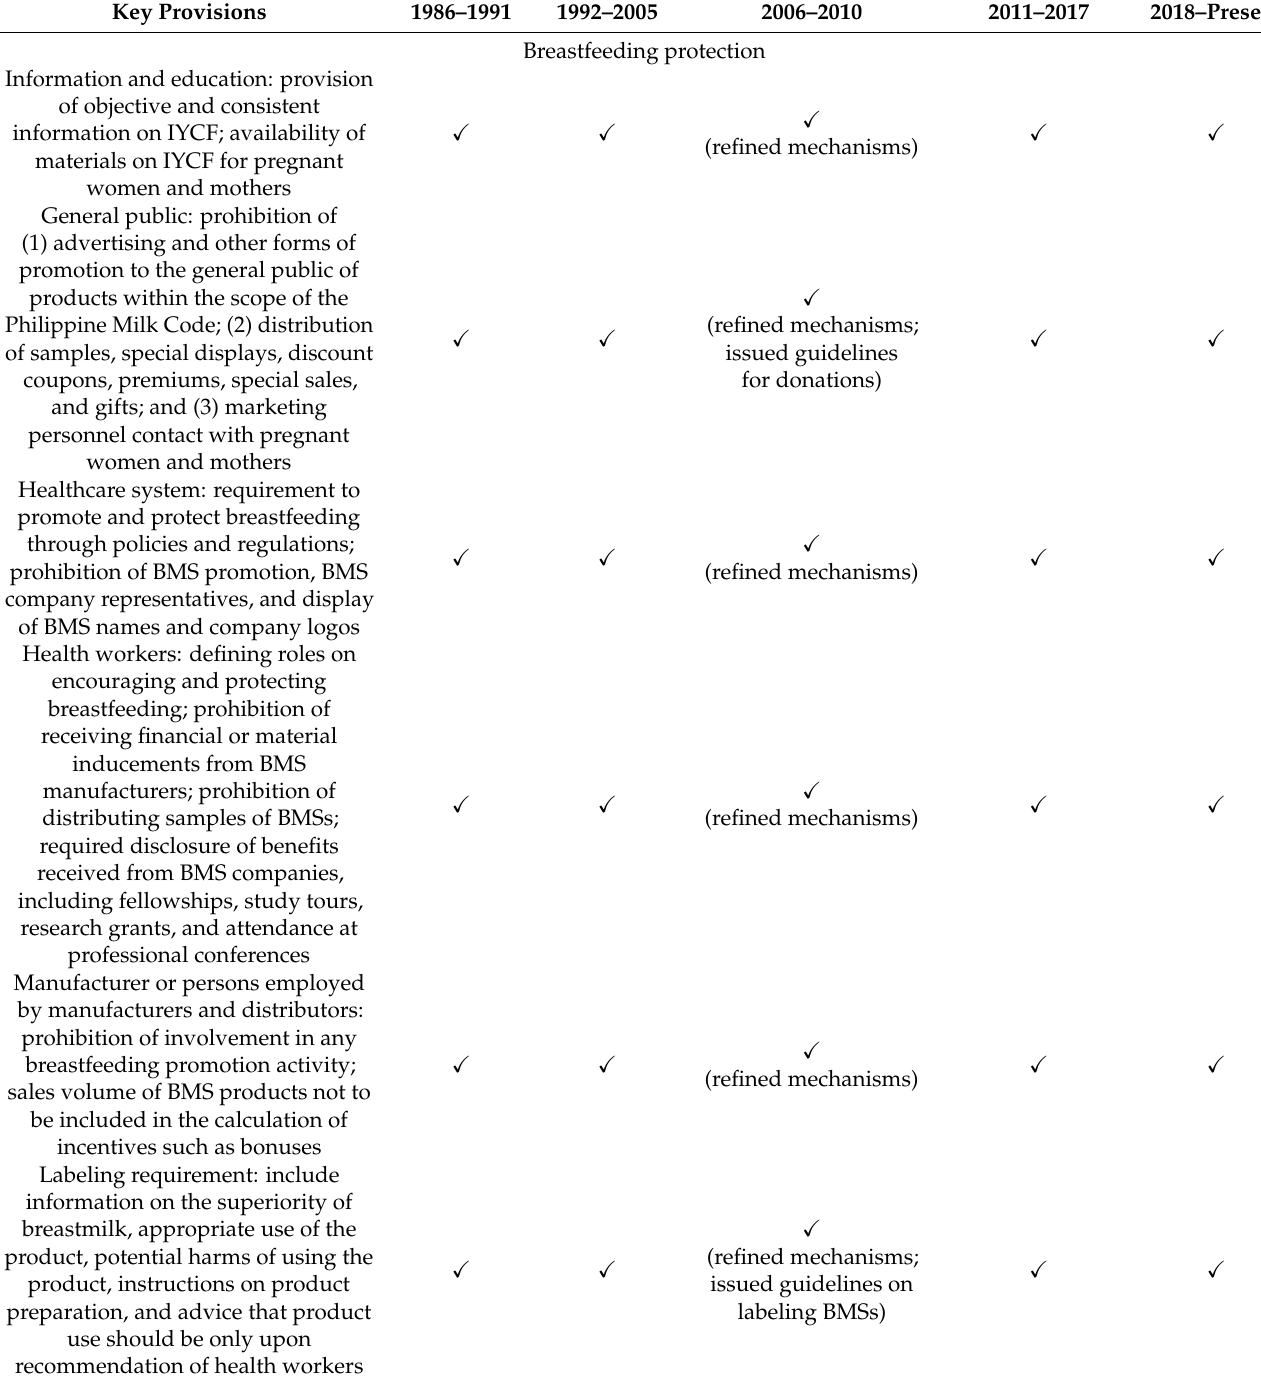
Table 2. History of key policy provisions on breastfeeding protection, promotion, and support in the